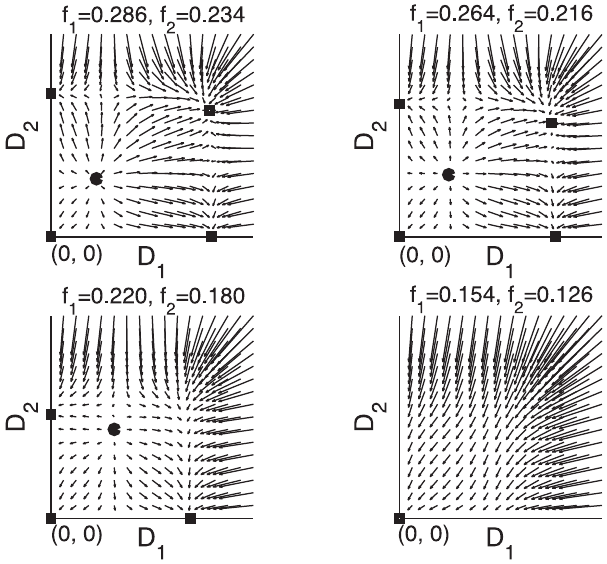
Figure 5. Global decrease of OTRs leads to vessel rarefaction. For the parallel system shown in Figure 1 (C), the OTRs of the two switches are different. When the OTRs decrease with the ratio f 1 = f 2 fixed, the stable co-existing equilibrium state becomes unstable. Similarly, for complex vessel systems, when there is a global decrease of the OTRs, the vessels with small OTRs may become degenerate and micro-vessel rarefaction occurs. If the OTRs decrease too much, there can be a global degeneration of the vessel